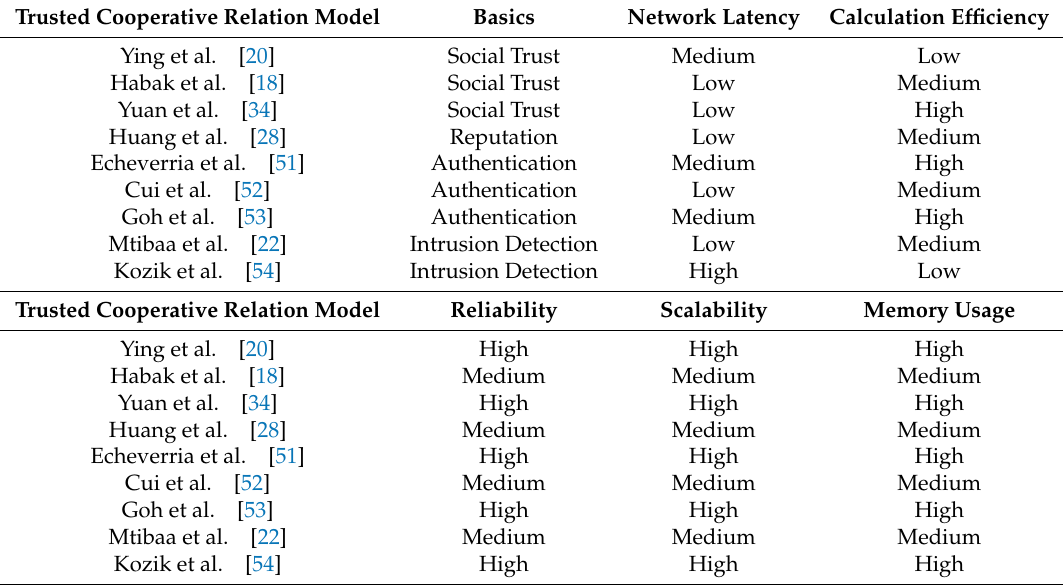
Table 1. Comparison of trusted cooperative relation models for MEC I.